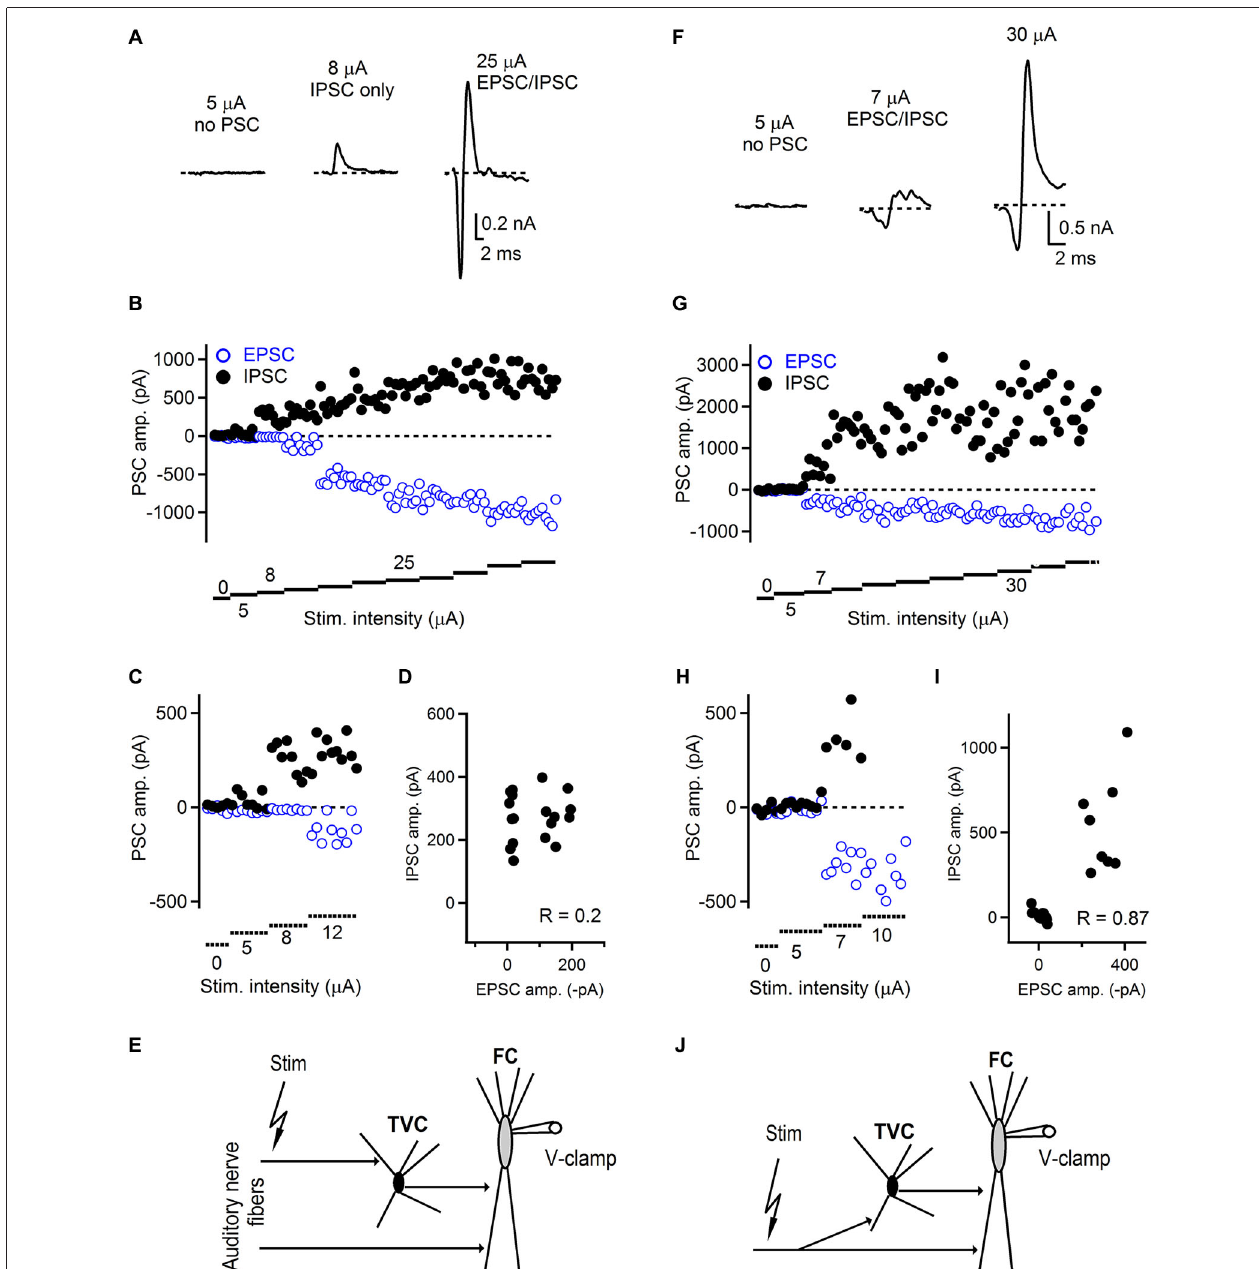
innervation pattern described in A–D . Separate auditory nerve fibers innervate the fusiform (FC) and tuberculoventral (TVC) cells. ∼ 54% (7/13) of FCs tested exhibited this type of innervation. (F) Representative examples of FFI and innervation pattern in which the same set of auditory nerve fibers innervates both tuberculoventral and FCs. Following failures in both EPSCs and IPSCs, both components appeared with the same threshold. Stimulation artifacts in A and F were removed for clarity and all traces represent averages of 5–10 trials. (G) With increasing stimulation intensity both components increased in their amplitude until both of them reached saturation. (H) Plot of low stimulation evoked EPSC/IPSC amplitudes shown at expanded scale. (I) Plot of IPSC vs. EPSC amplitudes showing high correlation ( R = 0.87) between IPSCs and EPSCs. (J) A schematic drawing of the innervation pattern shown in F–I . ∼ 46% (6/13) of FCs tested exhibited this type of